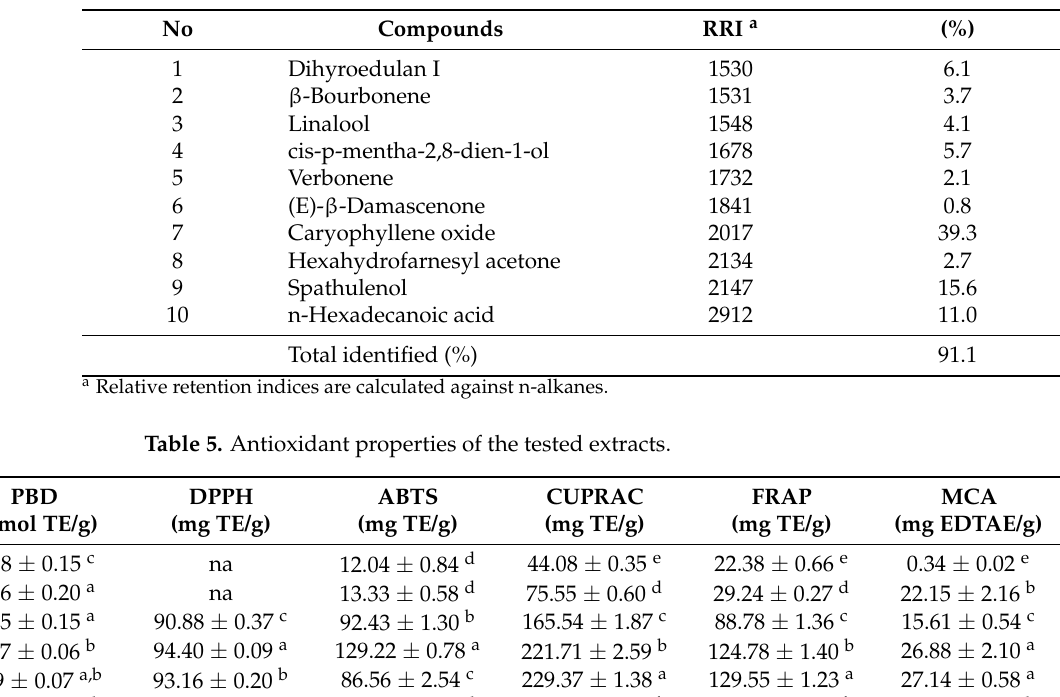
Table 4. Chemical profile of the tested essential oil.